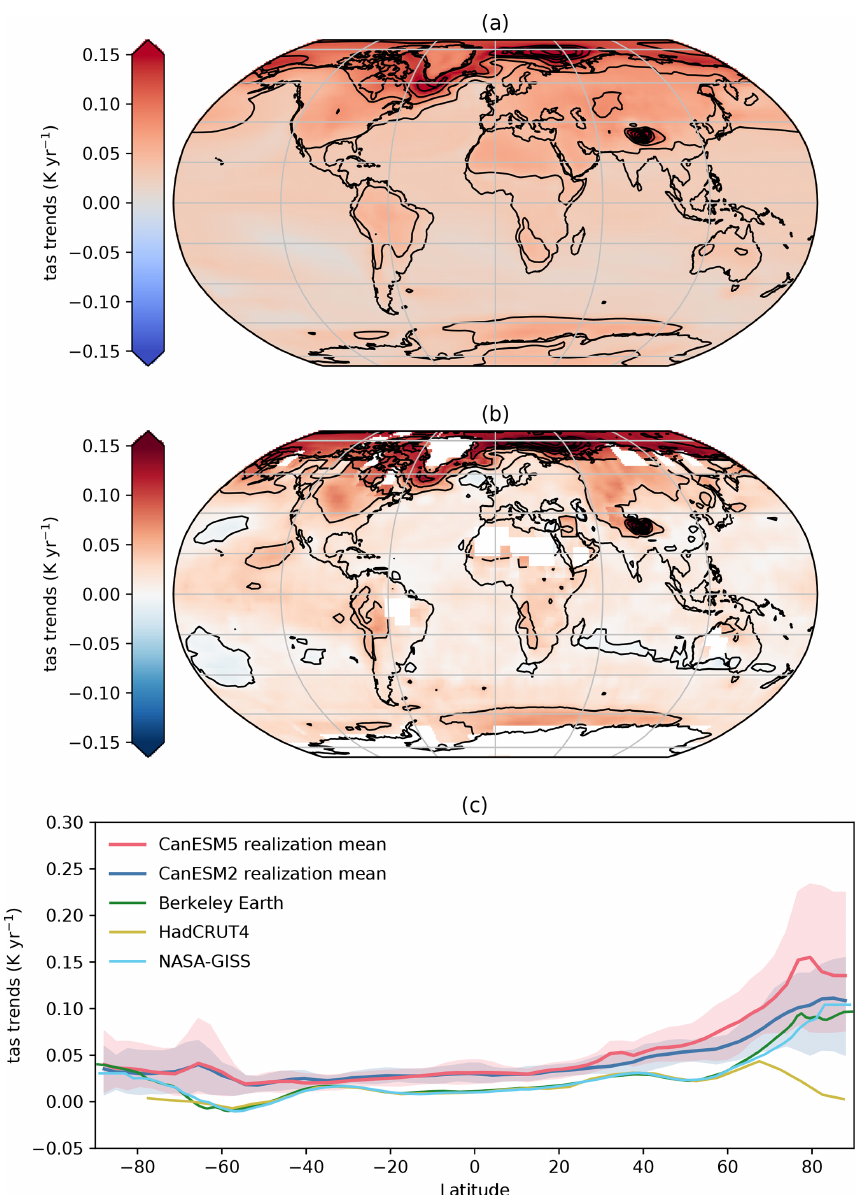
Figure 26. Surface temperature trends in CanESM5 (a) , the difference in trend between CanESM5 and HadCRUT4 (b) , and zonal mean of trends in CanESM2, CanESM5, and HADCRUT4 over 1981 to 2014 (c) . The shaded envelopes in panel (c) represent the range over the CanESM2 50-member large ensemble and the CanESM5 25-member “p1”